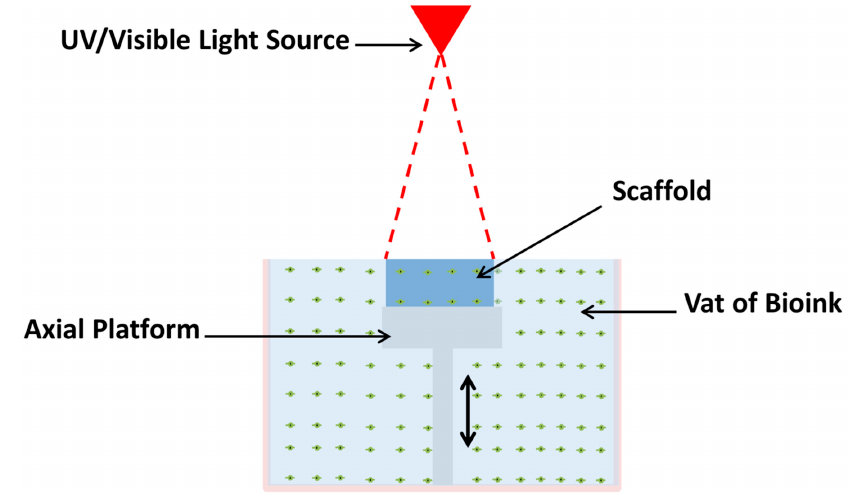
Figure 3. Schematic of Stereolithography Bioprinting. Photopolymerization occurs on the surface of the vat where the light-sensitive bioink is exposed to light energy. Axial platform moves downward the Z-axis during fabrication. This layer-by-layer technique does not depend on the complexity of the design, rather on its height. Photoinitiators are chemical molecules that create reactive agents when exposed to light energy, which react with monomers of a material to then initiate the formation of polymer chains.